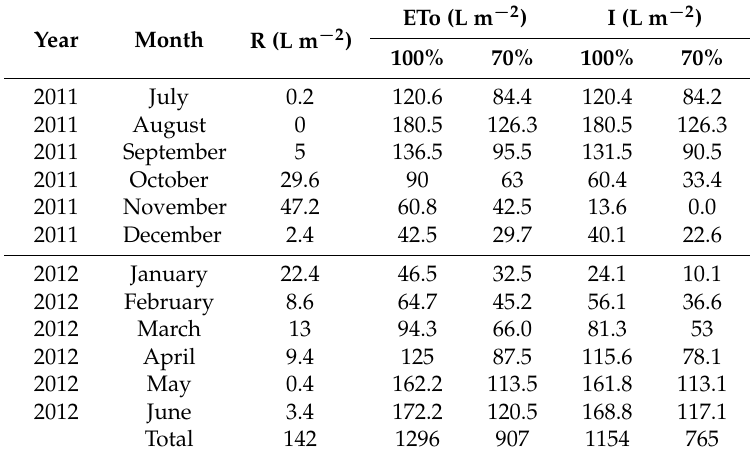
Table 3. Monthly values of rainfall (R), evapotranspiration (ETo), and irrigation (I) in each water treatment throughout the experimental period (years 2011 and